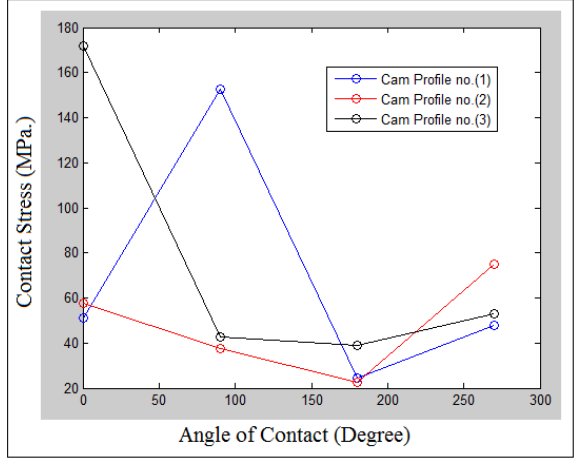
angle of contact for cam profile no.(2) and cam profile no.(3). The contact stress is varied sinusoidally against the angle of contact for cam profile no.(1). It can be concluded from Figure 26 that the nonlinear dynamics phenomenon of the follower is at the highest level on the nose location for cam profile no.(3), while the lowest level of the nonlinear dynam- ics phenomenon of the follower occurred at the base circle location for cam profile no.(1) and cam profile no.(2).